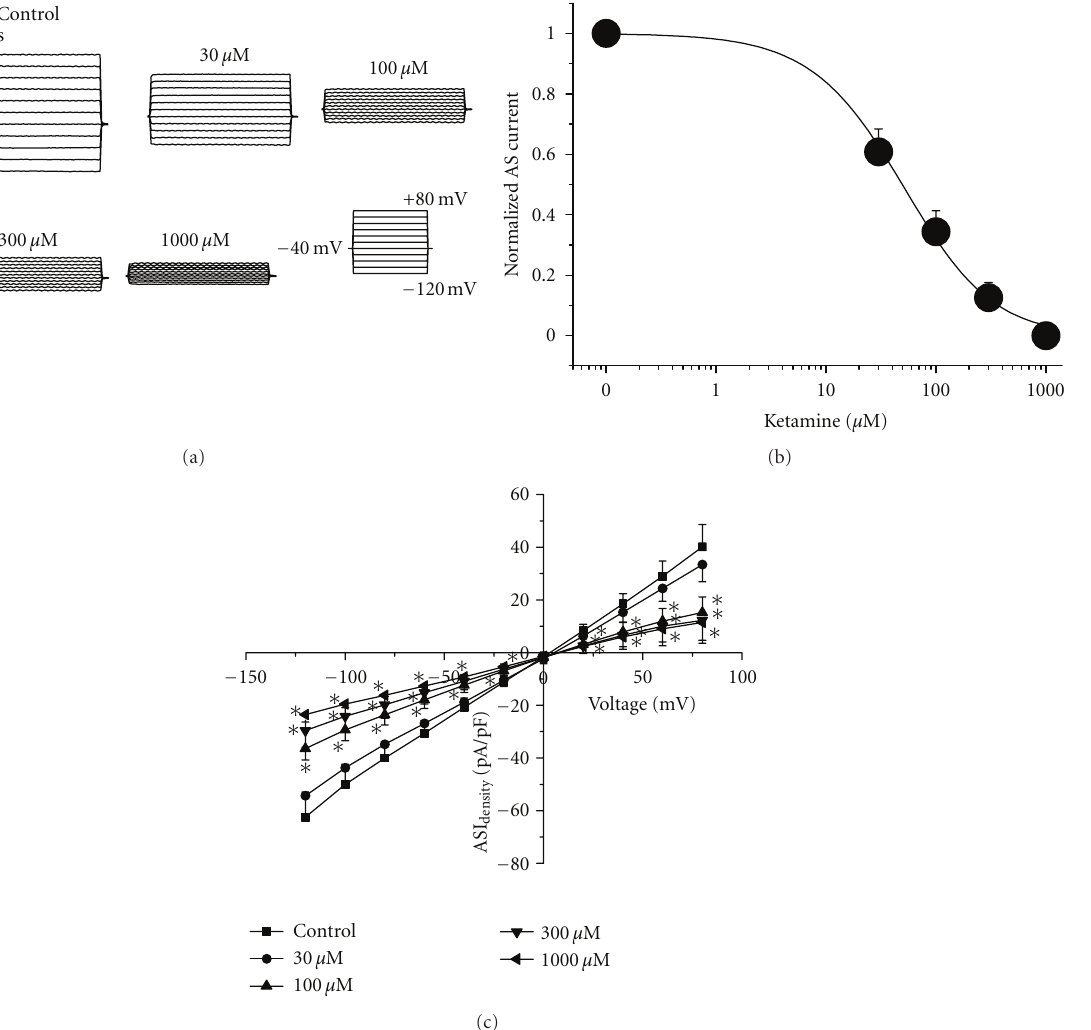
Figure 2: Patch clamp recordings of amiloride-sensitive currents in A549 cells. (a) Representative recordings of amiloride-sensitive current traces in a cell before (control) and after delivery of di ff erent concentrations of ketamine (30 μ M to 1mM) to the bath. (b) Concentration- dependent inhibition of whole-cell currents by ketamine. For each cell, inward currents recorded at − 100 mV were measured during perfusion with external solutions. Amiloride-sensitive (AS) currents were normalized to the current at − 100 mV of control. IC 50 was calculated by best fitting the raw data points to the Hill equation. Inorm = 1/(1 + (ketamine/IC 50 )) coe . (c) Amiloride-sensitive current density- (ASI density -) voltage curves for average control currents (control), in the presence of di ff erent concentrations of ketamine (30 μ M to 1mM). Average values are presented as the mean ± SEM. One-way ANOVA. ∗ P < 0 . 05, n =